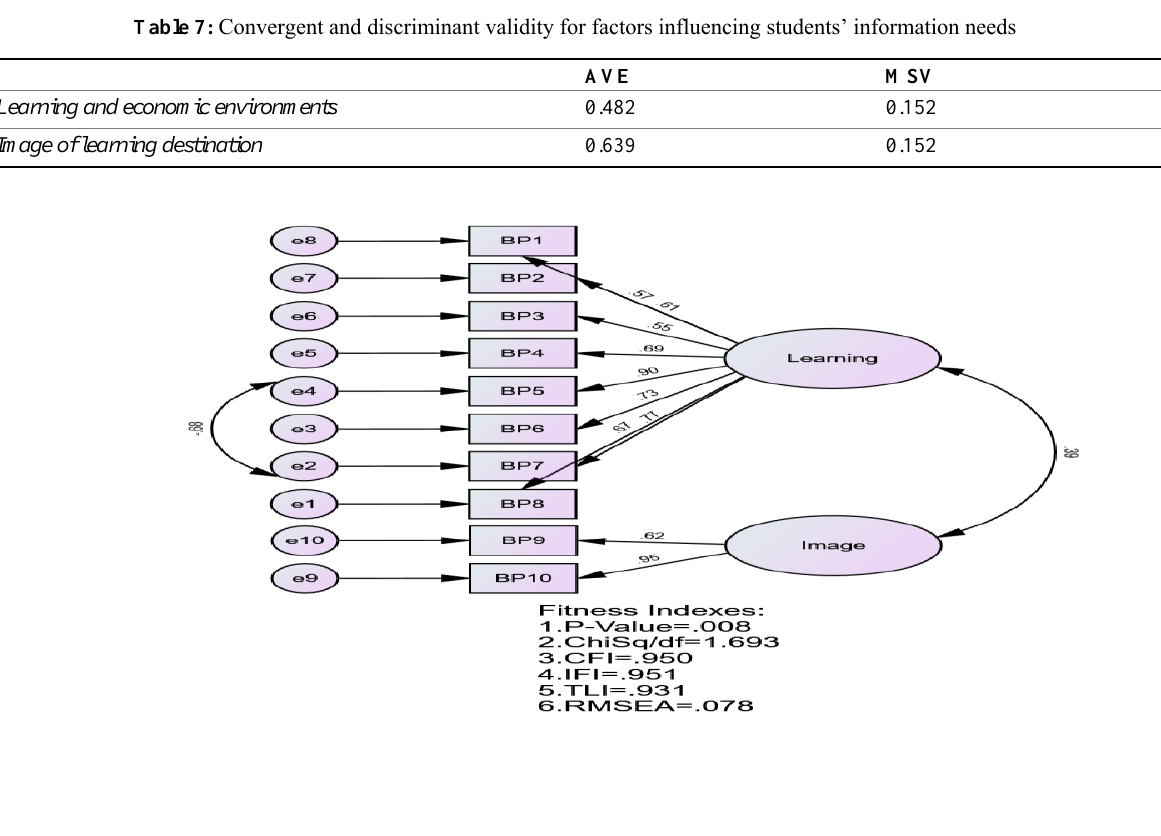
Figure 1: CFA for factors influencing students’ information